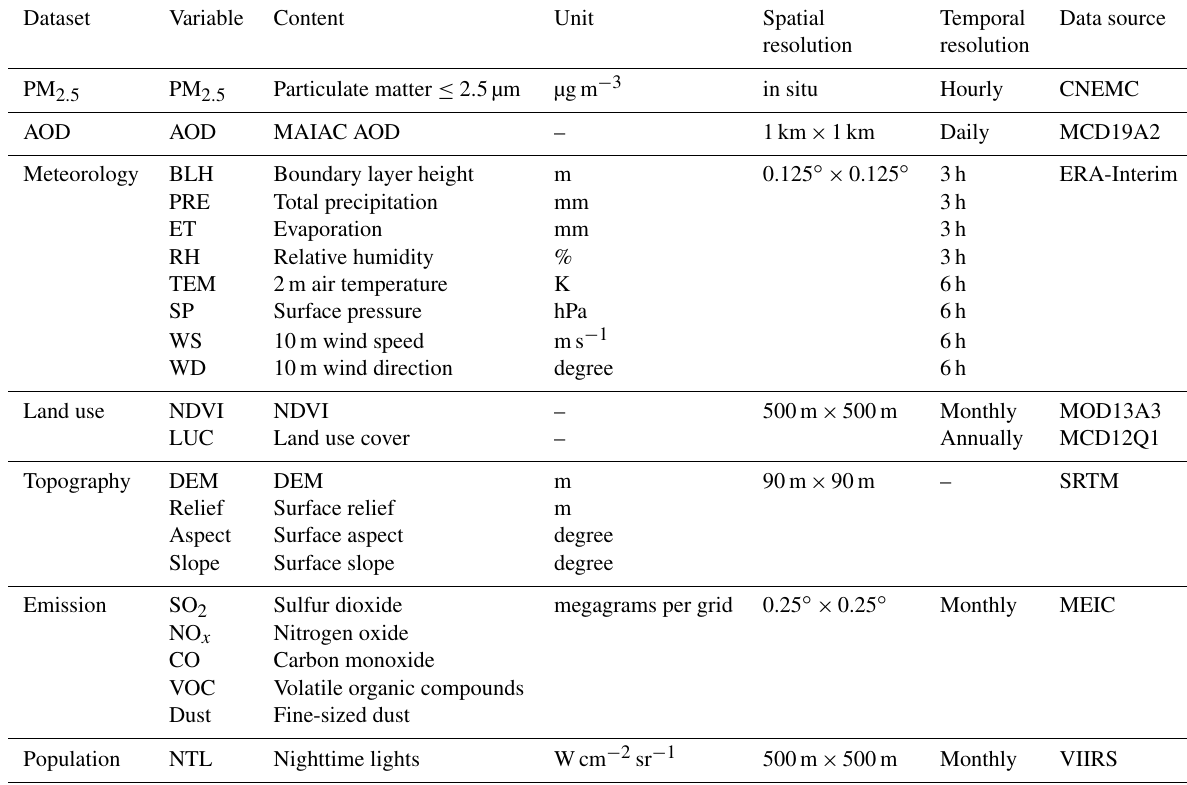
Table 1. Summary of the data sources used in this study.